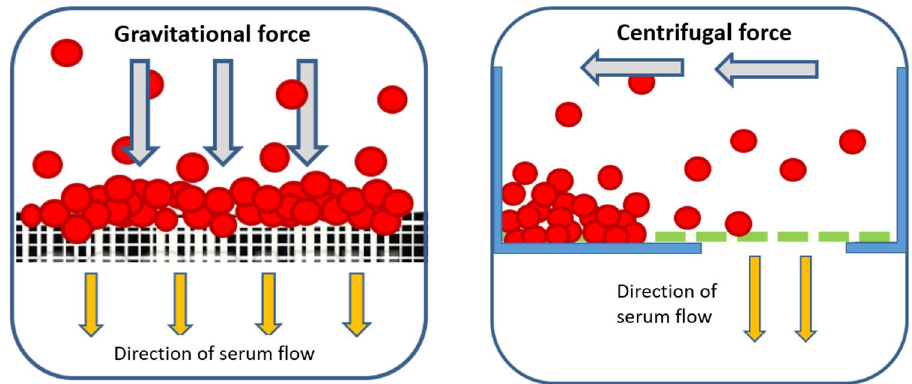
Figure 1. A schematic depicting the difference between the separation of serum from blood via dead-end filtration (left), which tends to cause clogging of membrane pores, and cross-flow filtration (right). Red circles represent